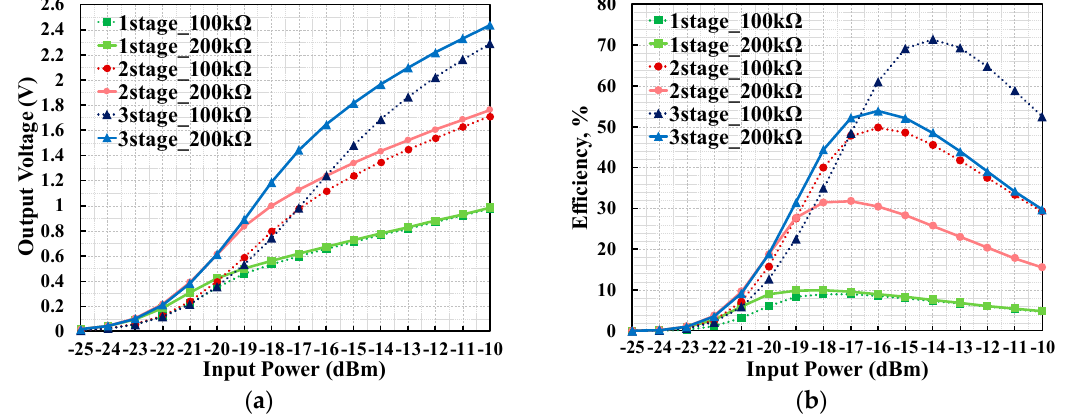
Figure 5. Simulation results of the rectifier, ( a ) output voltage versus input power for different stages and load resistance; ( b ) efficiency versus input power for different stages and load resistance.